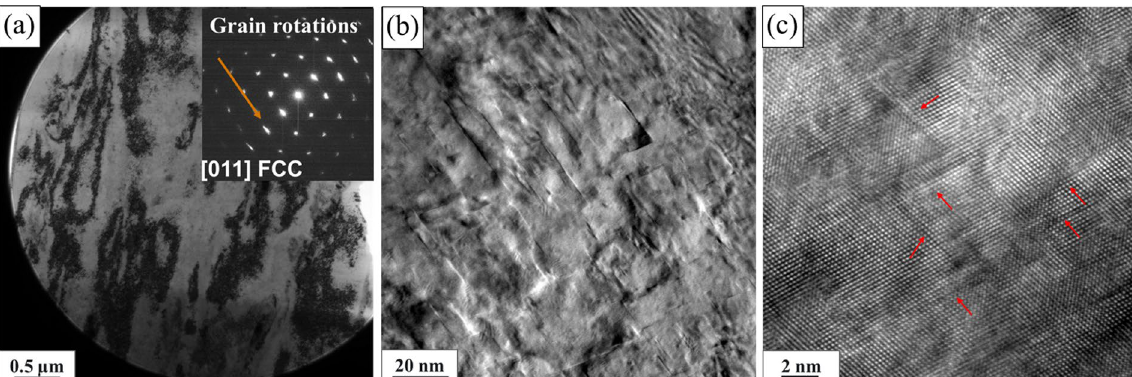
Figure 8. TEM characterization of the sample from an area close to the crater wall after high velocity ballistic impact of 1465 m/s: ( a ) Low magnification BF-TEM image showing high density of dislocation bands with the inset showing SADP pattern taken along [011] FCC ZA suggesting grain boundary rotation as marked with a red arrow and absence of L1 2 super lattice reflections; ( b ) BF-TEM and ( c ) HRTEM images showing high density of stacking